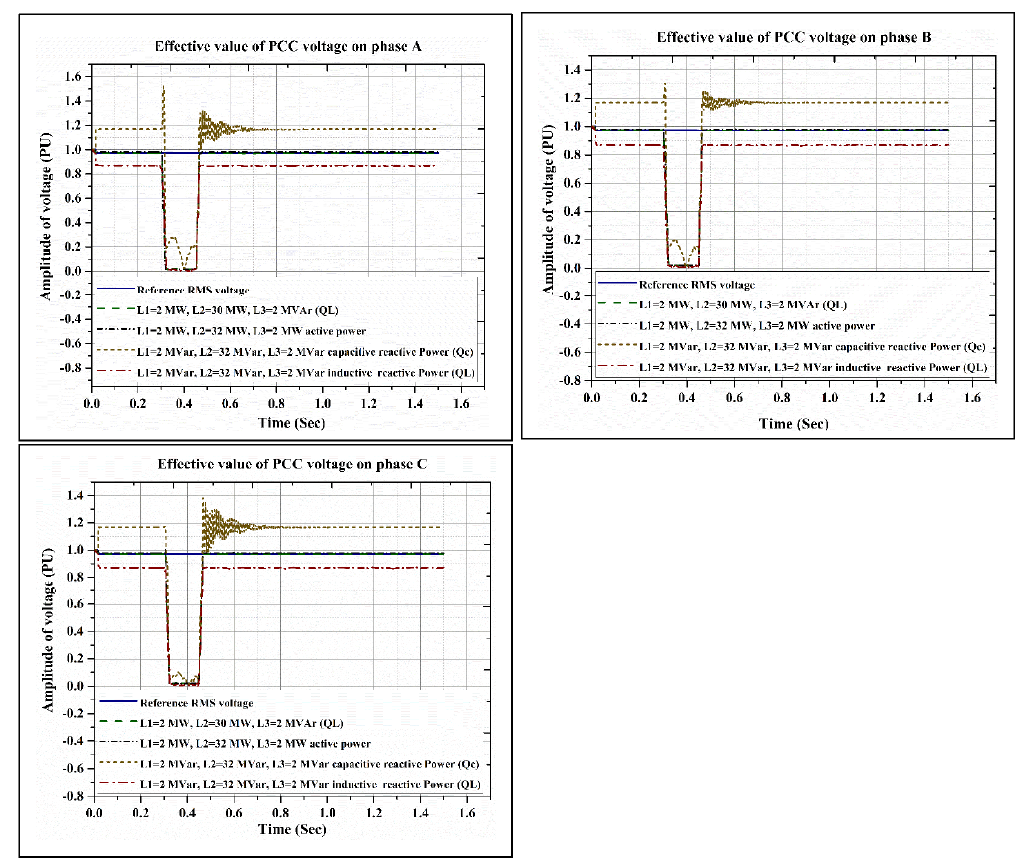
Figure 15. The effective value of PCC voltage when local loads are greater than local generation.